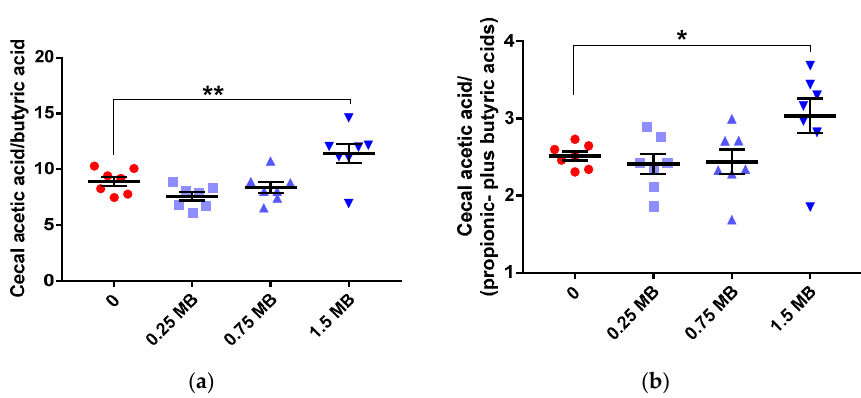
Figure 2. Cecal short-chain fatty acid concentrations in rats fed a high-fat control diet with butter (0), or the same diet supplemented with 0.25 MB g/100 g (dry weight basis) (0.25 MB), 0.75 MB g/100 g (0.75 MB) or 1.5 MB g/100 g (1.5 MB) for 3 weeks. ( a ) Acetic acid/butyric acid ( p ANOVA = 0.0006), ( b ) acetic acid/(propionic- plus butyric acids) ( p ANOVA = 0.0053). Values are means ± SEM. Mean values were significantly different from the control group: * p < 0.05, ** p < 0.01 (one-way ANOVA and post-hoc Dunnett’s test). MB, monobutyrin.